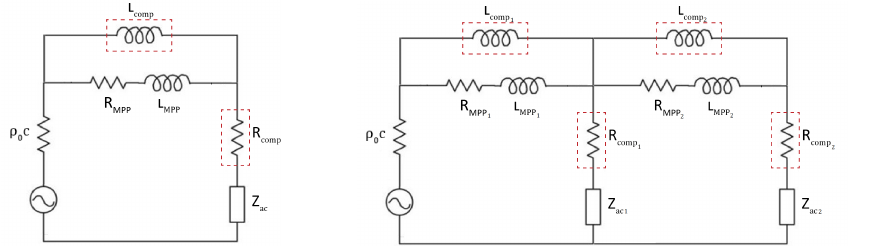
Figure 10. Electro-acoustical equivalent circuit for SL-MPP and DL-MPP configurations: the induc- tance L comp is in parallel with the MPP surface impedance Z MPP , and the resistance R comp is in series with Z MPP